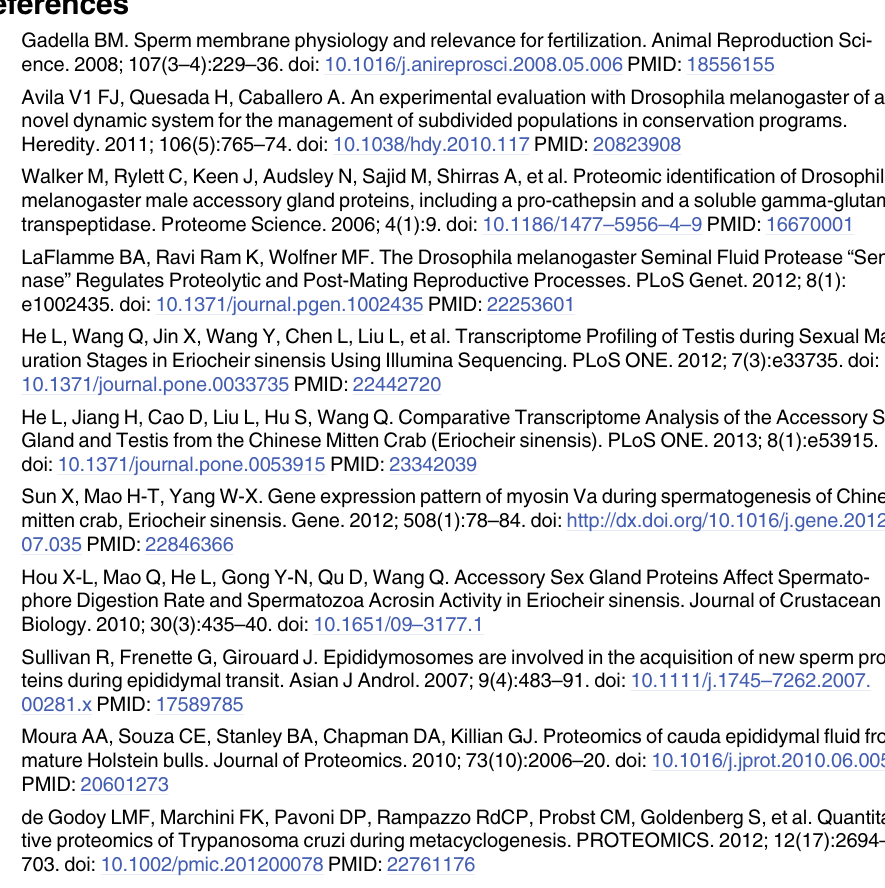
S2 Table. Identified peptides in AG proteomics from E . sinensis . S3 Table. Identified protein Groups in AG proteomics from E . sinensis . S4 Table. KEGG analysis for AG proteomics from E . sinensis . The Enzyme